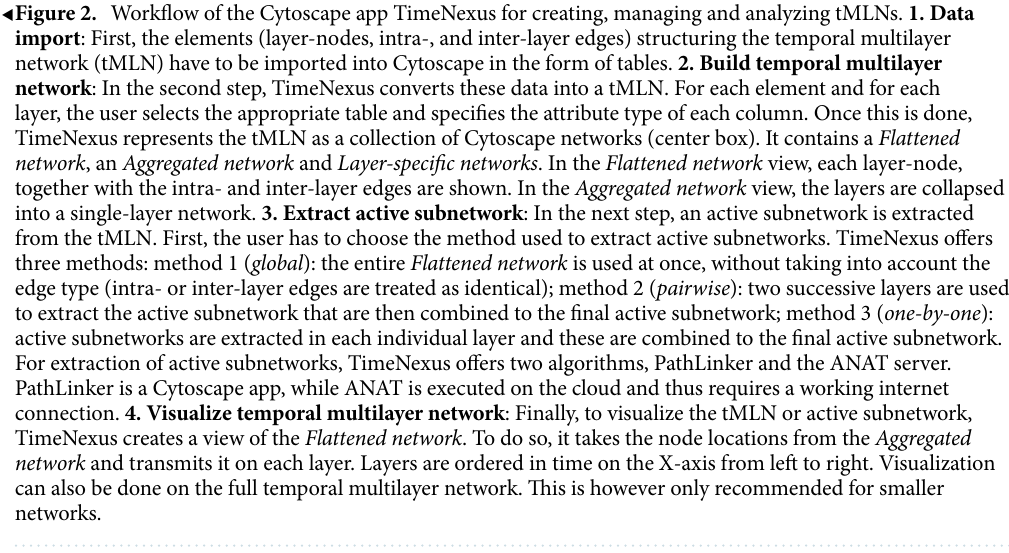
Figure 2. Workflow of the Cytoscape app TimeNexus for creating, managing and analyzing tMLNs. 1. Data import : First, the elements (layer-nodes, intra-, and inter-layer edges) structuring the temporal multilayer network (tMLN) have to be imported into Cytoscape in the form of tables. 2. Build temporal multilayer network : In the second step, TimeNexus converts these data into a tMLN. For each element and for each layer, the user selects the appropriate table and specifies the attribute type of each column. Once this is done, TimeNexus represents the tMLN as a collection of Cytoscape networks (center box). It contains a Flattened network , an Aggregated network and Layer-specific networks . In the Flattened network view, each layer-node, together with the intra- and inter-layer edges are shown. In the Aggregated network view, the layers are collapsed into a single-layer network. 3. Extract active subnetwork : In the next step, an active subnetwork is extracted from the tMLN. First, the user has to choose the method used to extract active subnetworks. TimeNexus offers three methods: method 1 ( global ): the entire Flattened network is used at once, without taking into account the edge type (intra- or inter-layer edges are treated as identical); method 2 ( pairwise ): two successive layers are used to extract the active subnetwork that are then combined to the final active subnetwork; method 3 ( one-by-one ): active subnetworks are extracted in each individual layer and these are combined to the final active subnetwork. For extraction of active subnetworks, TimeNexus offers two algorithms, PathLinker and the ANAT server. PathLinker is a Cytoscape app, while ANAT is executed on the cloud and thus requires a working internet connection. 4. Visualize temporal multilayer network : Finally, to visualize the tMLN or active subnetwork, TimeNexus creates a view of the Flattened network . To do so, it takes the node locations from the Aggregated network and transmits it on each layer. Layers are ordered in time on the X-axis from left to right. Visualization can also be done on the full temporal multilayer network. This is however only recommended for smaller subnetwork. The query node attribute can for instance be defined based on the log2 fold change of the layer-node surpassing a selected cut-off and must either be TRUE or FALSE . Query nodes on each of the layers are thus pre- set by the user. Additional layer-specific attributes such as the weight for each layer-node in form of a numerical value can be provided, for instance reflecting the differential expression at each time point. The interactome of a tMLN is assumed to be the same at each layer. It should however be noted that TimeNexus can also handle multilayer networks that are not multiplex. In this case, the user has to provide one node table for each layer. The intra-layer edge table contains the information to build the interactome, which is common to each layer. This table contains the edge information of the interacting nodes (proteins or genes). A weight can be given to each intra-layer edge, for instance in form of a confidence score for the interaction. The type of interaction (pro- tein–protein interaction (PPI) or protein-DNA interaction (PDI)) can be distinguished by adding an optional attribute to each edge. The optional inter-layer edge table has the same format as the intra-layer edge table, but it defines the edges connecting the nodes from one layer to the next. In our example of a tMLN, the inter-layer edges connect the same layer-nodes from two different, consecutive layers. Their attributes represent weights, the so-called inter-layer edge weights, which are calculated by combining the weights of the source and target nodes. Thus, they carry information on the change in expression of that node between two time points. The inter-layer edge weights are used by the extracting apps for identifying active subnetworks. If the inter-layer edge table is not provided, TimeNexus will automatically create these inter-layer edge weights (see below). See Supplementary Tables S1-S3 for examples for the node table and the intra- and inter-layer edge tables. To create a tMLN, at least 2 layers are required.